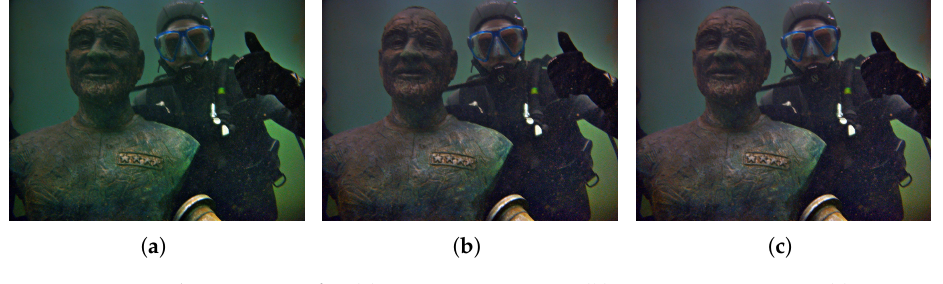
Figure 6. Empirical parameters for ( a ): α = 20, β = 20; ( b ): α = 125, β = 46; ( c ): α = 219, β = 69. Compared to the optimal parameters in ( b ), small values for ( a ) brought about unsatisfactory correction for color distortion, while large values for ( c ) resulted in